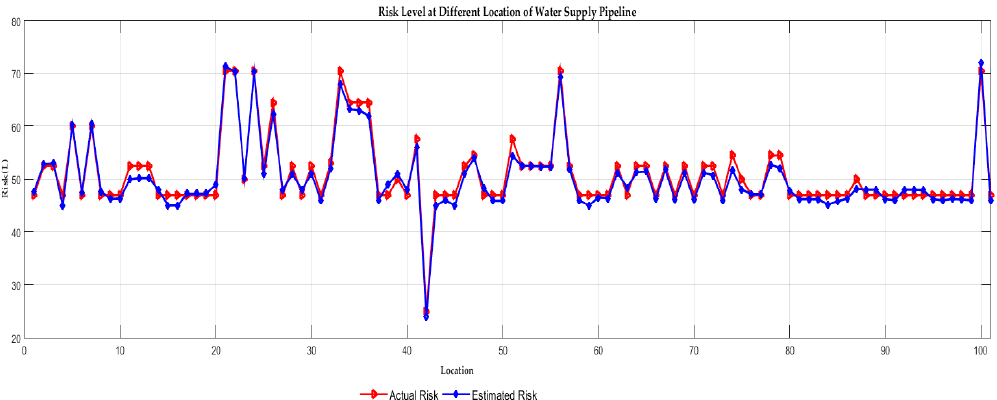
Figure 17. The actual risk index and blended hierarchical fuzzy logic risk index at different locations.